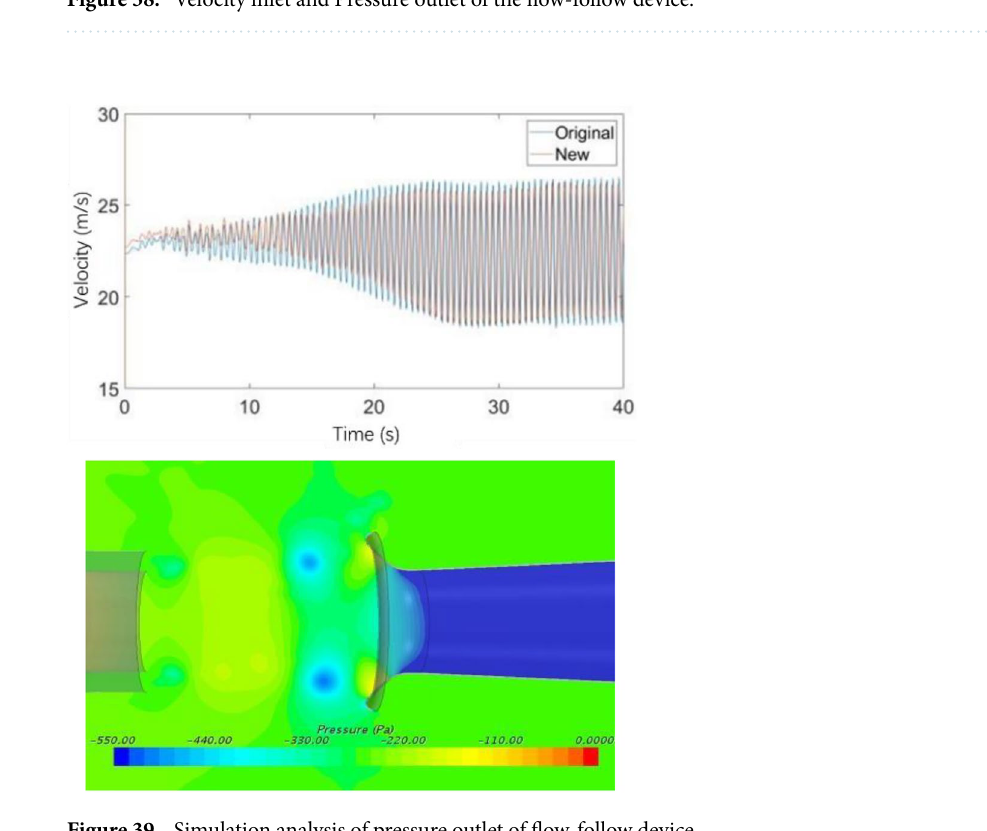
Figure 39. Simulation analysis of pressure outlet of flow-follow